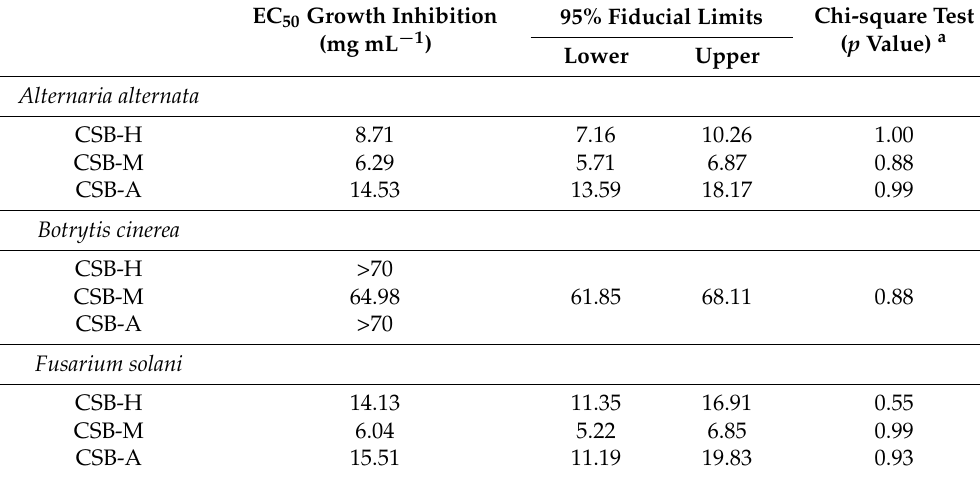
Table 3. EC 50 of CSB extracts inhibiting Alternaria alternata , Botrytis cinerea and Fusarium solani mycelial